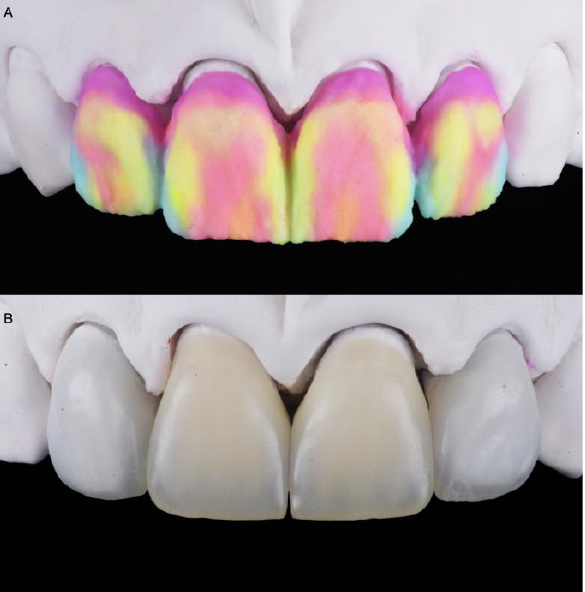
Figure 8. Feldspathic veneers on the master cast: ( A ) Porcelain build-up before baking; ( B ) Definitive restorations.